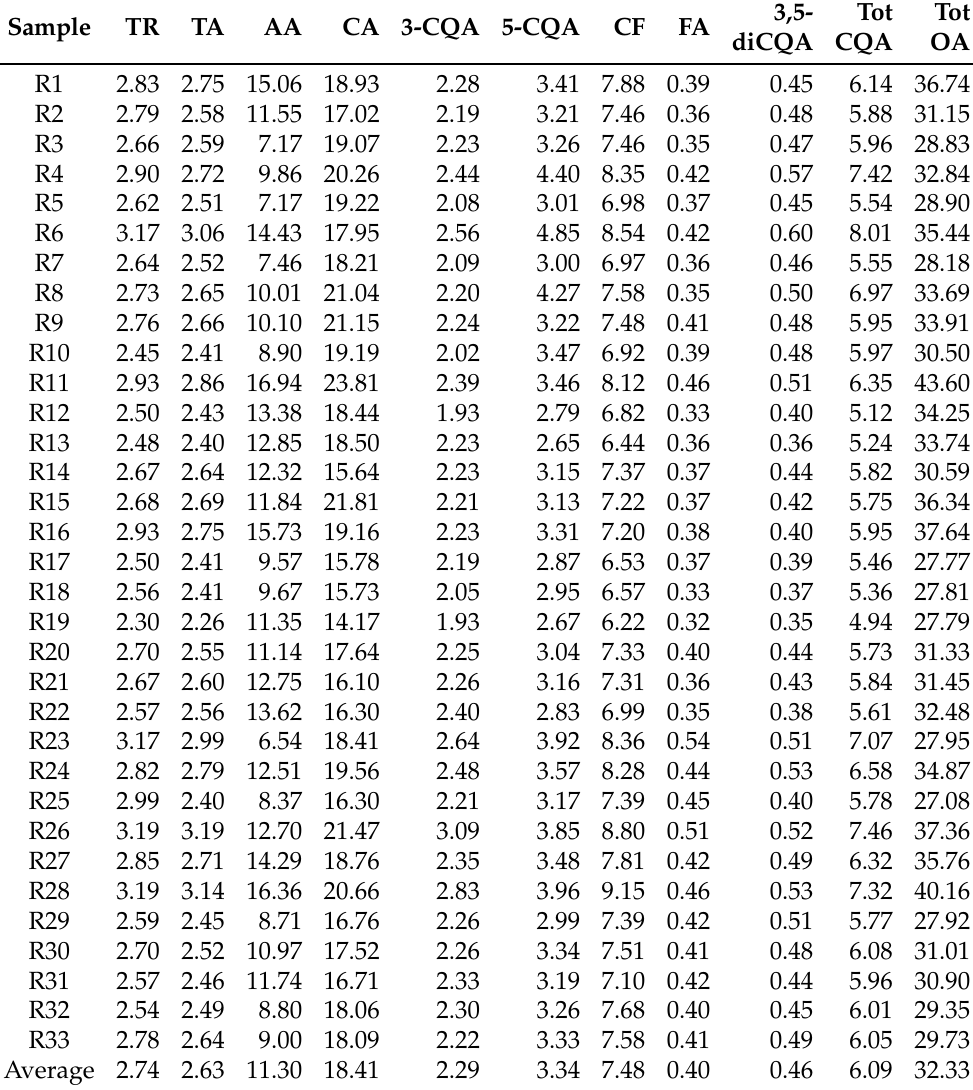
Table 5. Contents of bioactive compounds (g/L) found in Robusta EC samples. TR denotes trigonelline, TA tartaric acid, AA acetic acid, CA citric acid, CF caffeine, FA ferulic acid, CQA chlorogenic acid, OA organic acid. % RSD for all compounds are from 0.1 to